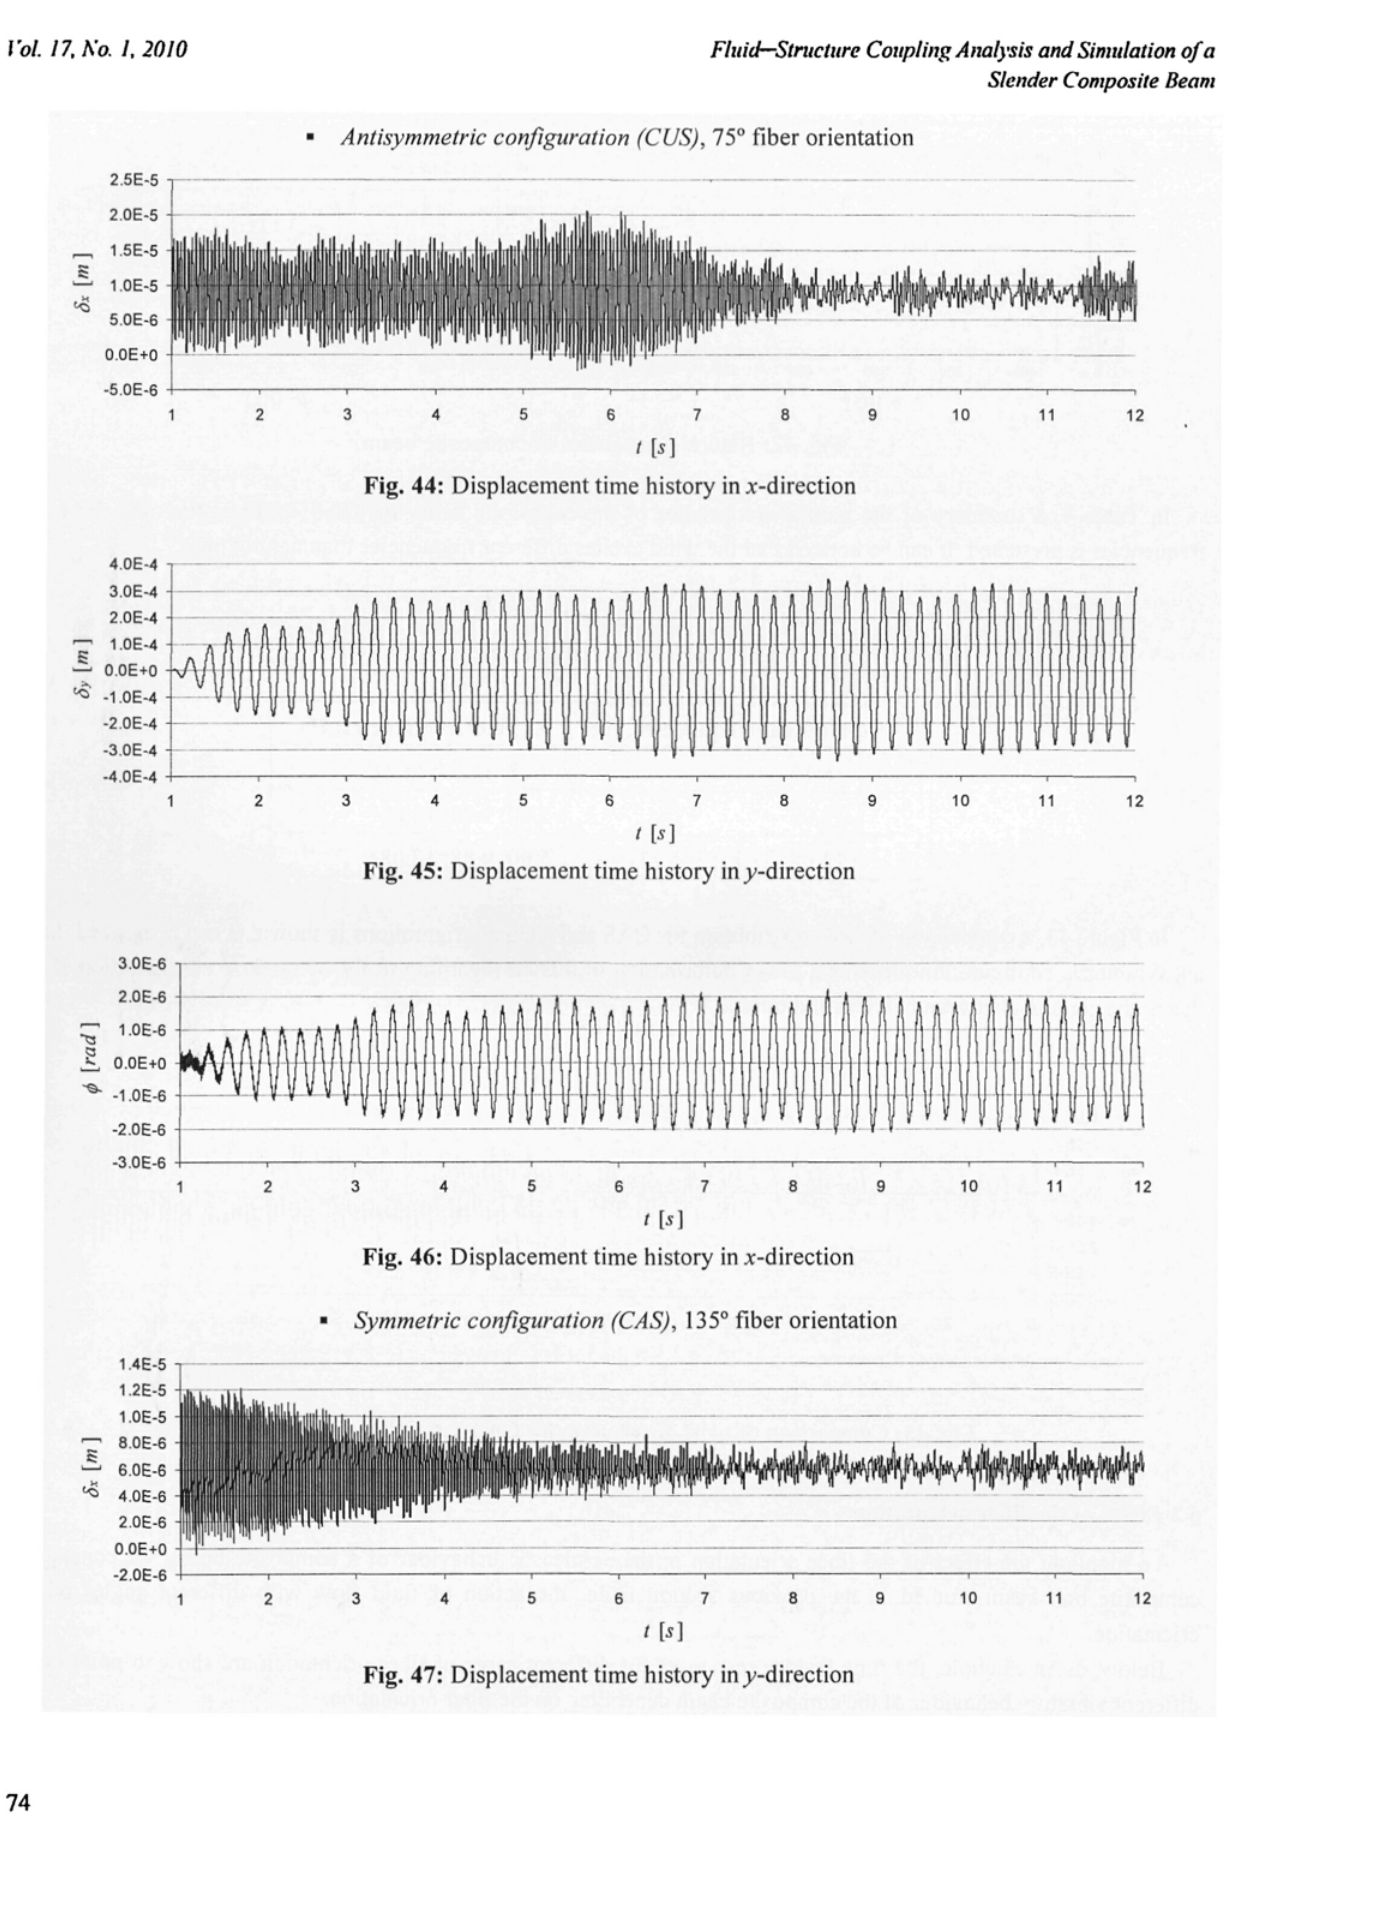
Fig. 47: Displacement time history in